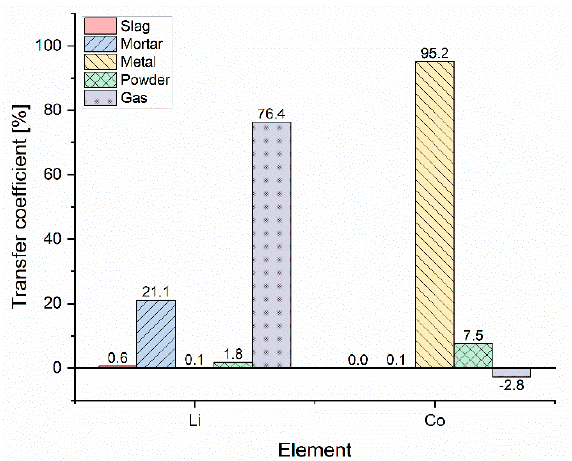
Figure 10. Transfer coefficients of the elements into the individual fractions in % of the experiment in Design 1.